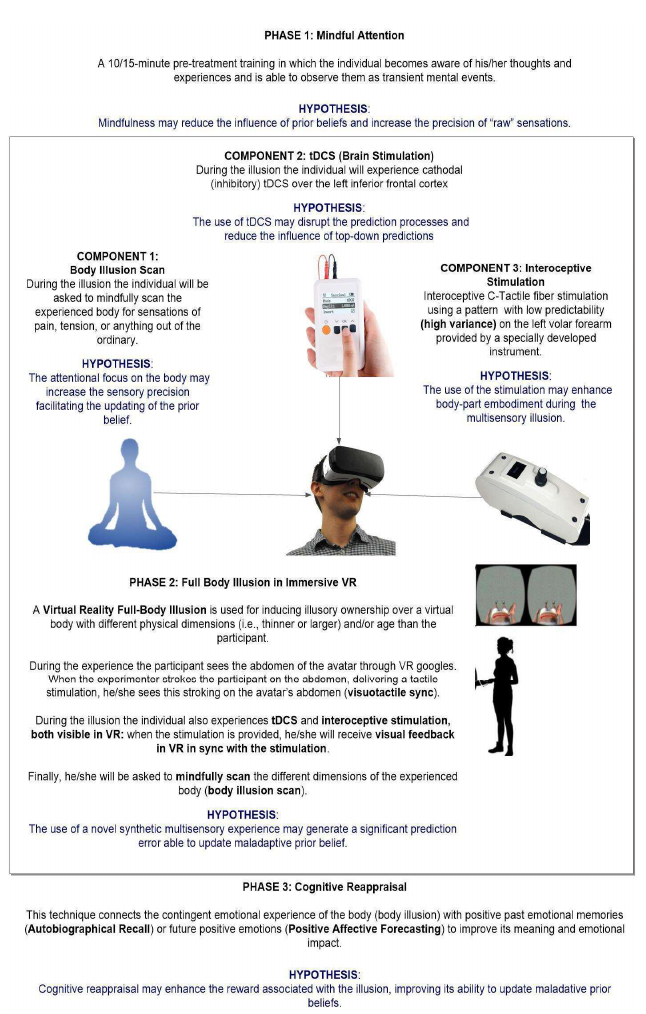
Figure 2. The different tools used in Regenerative Virtual Therapy (Adapted from Riva et al., 2021 [143]). tDCS: transcranial Direct Current Stimulation; VR: Virtual Reality.